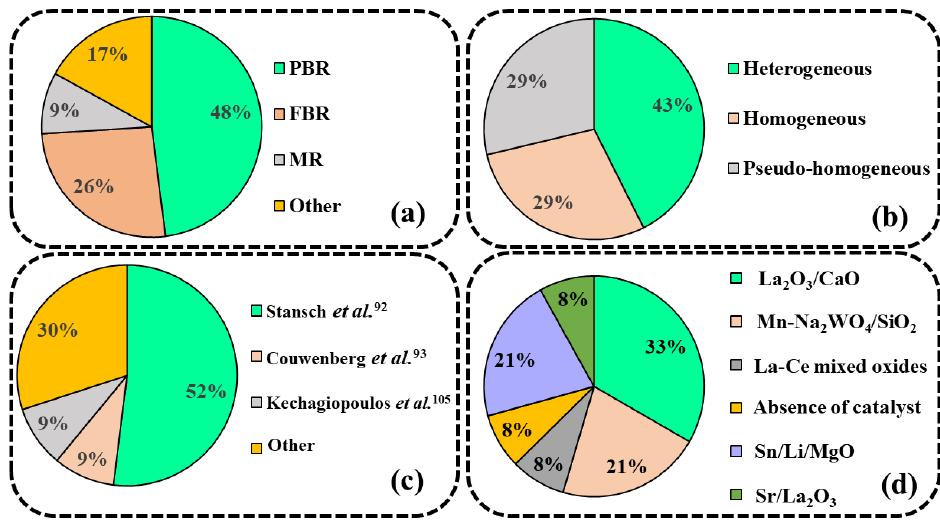
Figure 14. Distributions of types of reactors ( a ), models ( b ), kinetic mechanisms ( c ) and catalysts ( d ) used in modelling studies. Percentages have been calculated from a sample of 30 papers.